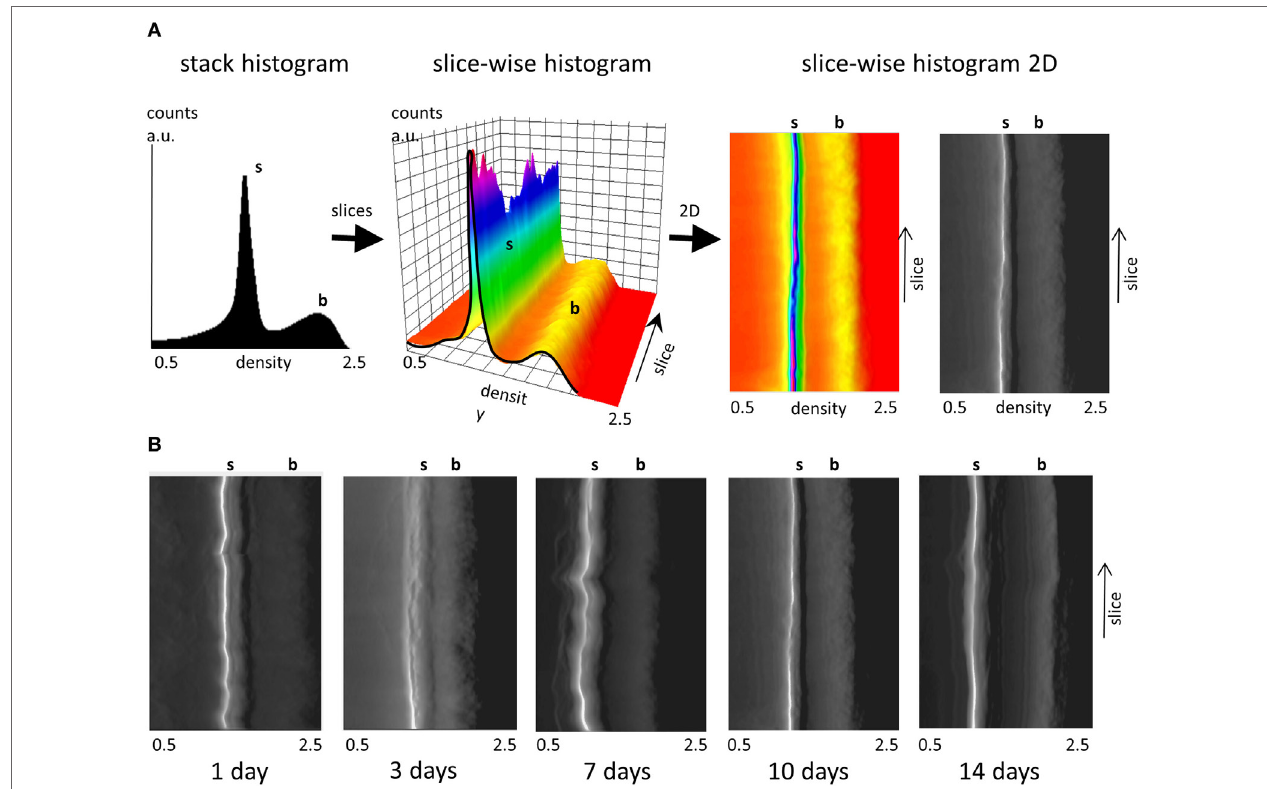
FigUre 3 | Slice-wise density distributions along the femur midshaft axis. (a) Transformation of a stack histogram (left) to a pseudo-3D plot of all histograms (middle) along the different slices in femur midshaft axis. The color histogram highlights the counts. When the plot is viewed from above, (right) and converted into grayscale the plot highlights the location of the soft tissue (white) and the bone peak (transition from dark gray to black). Densities between 0.5 and 2.5 g/cm 3 are presented and the soft tissue and bone peak positions are highlighted (s, b). (B) Projected pseudo-3D slice-wise histograms of data stacks from 1-, 3-, 7-, 10-, and 14-day